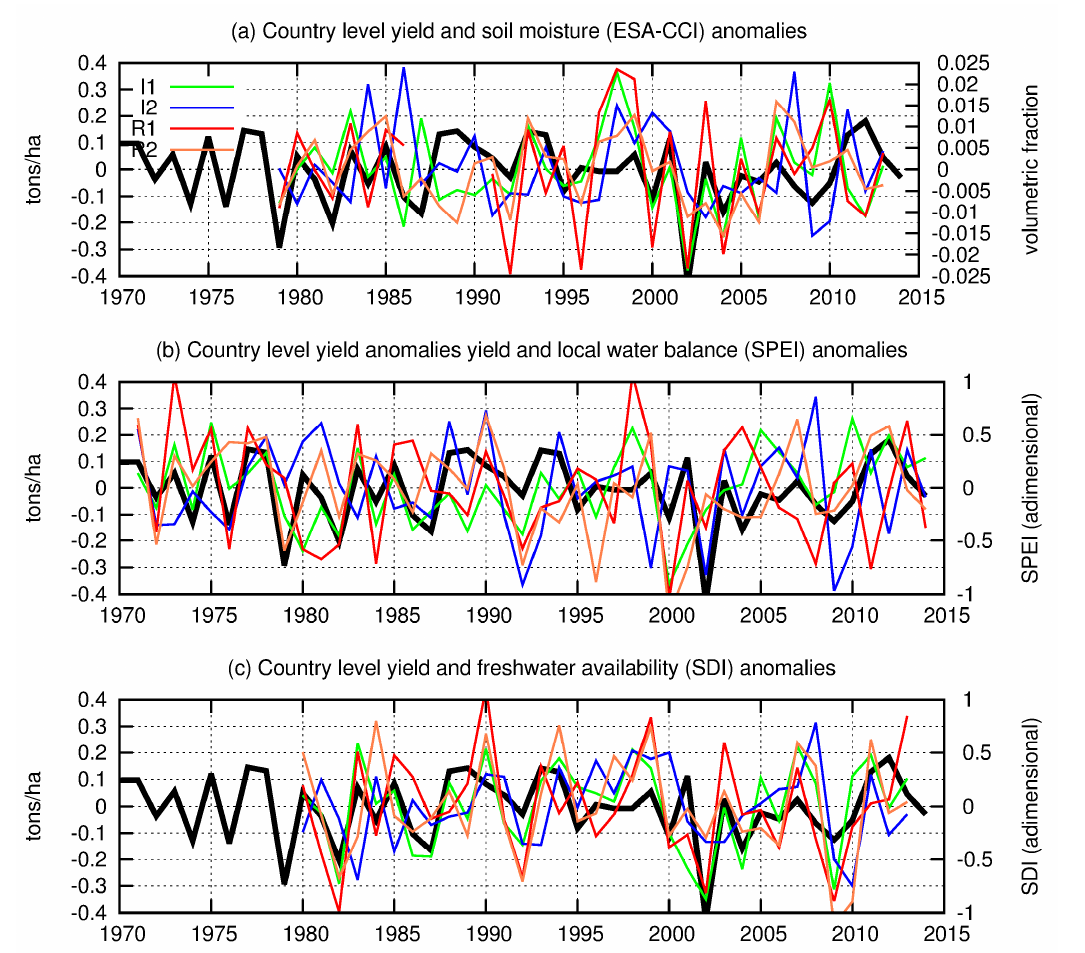
Figure 7. Time series of yield anomalies (black lines): ( a ) top soil moisture observations (ESA-CCI) and climate indicators for ( b ) the local water balance (SPEI, middle panel) and ( c ) surface freshwater availability (SDI, lower panel) aggregated at the country level but distinguished for cropping cycles: irrigated rice I1 in green, I2 in blue, rainfed rice R1 in red and R2 in orange. The same yield anomaly shown in Figure 6 is reported here as well, as a reference.